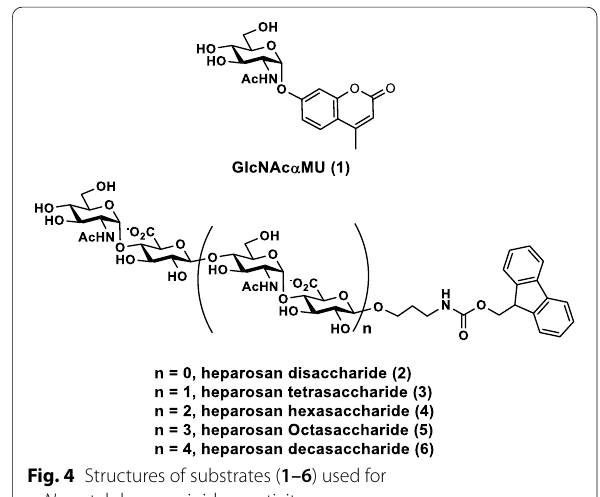
Fig. 4 Structures of substrates ( 1–6 ) used for α‑ N ‑acetylglucosaminidase activity assays